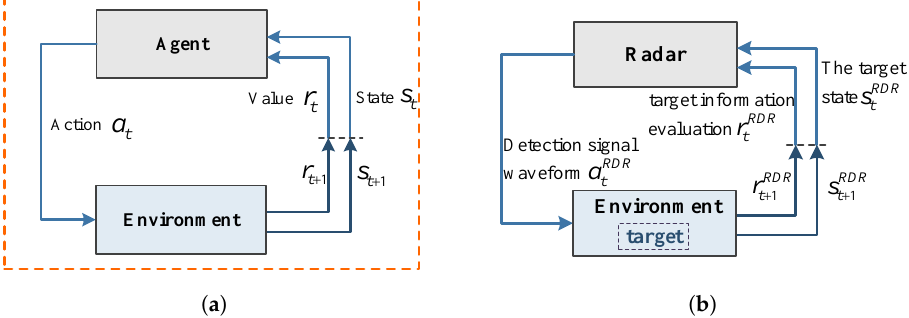
Figure 4. Comparison chart of basic RL theory model and single radar system model. ( a ) Basic reinforcement learning model framework, ( b ) Intelligent radar anti-jamming model. Table 1. Parameter definition of RL model based on single radar